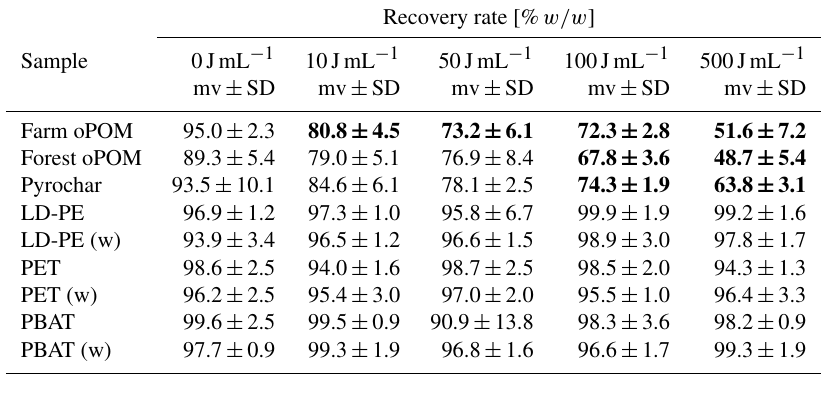
Table 1. Recovery rates of natural POM and microplastics from after ultrasonic treatment with 0, 10, 50, 100 and 500JmL − 1 ( n = 3). The (w) marks weathered plastics, mv the mean value and SD the standard deviation. Bold numbers are significantly different from the 0JmL − 1 treatment by p < 0 . 05.